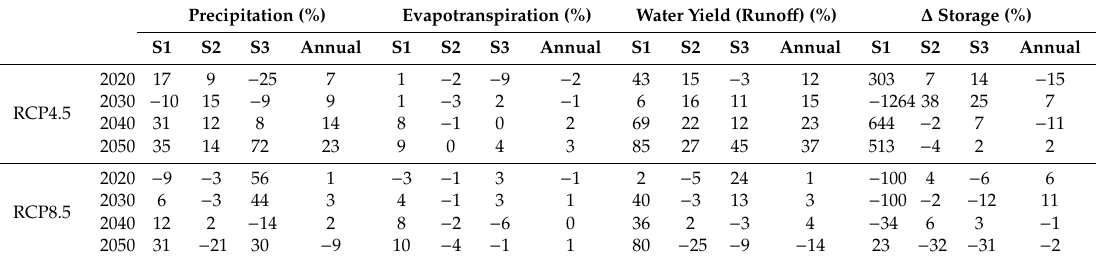
Table 4. Impacts of climate change on hydrology considering baseline data of 2010. S1 is pre-monsoon season (March–May); S2 is monsoon season (June–September); and S3 is post-monsoon season (October–February).